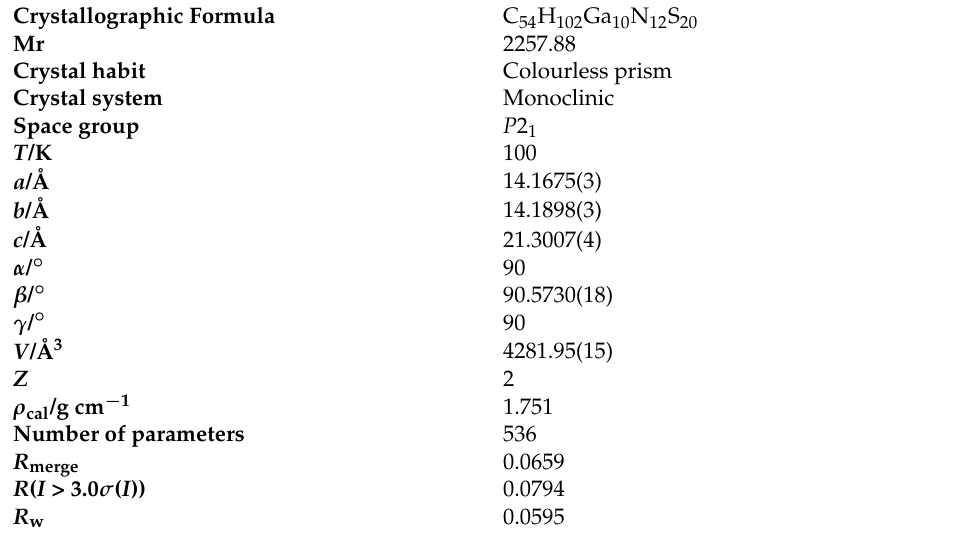
Table 1. Selected crystallographic data for [C 9 H 17 N 2 ] 6 [Ga 10 S 16 (SH) 4 ]. Crystallographic